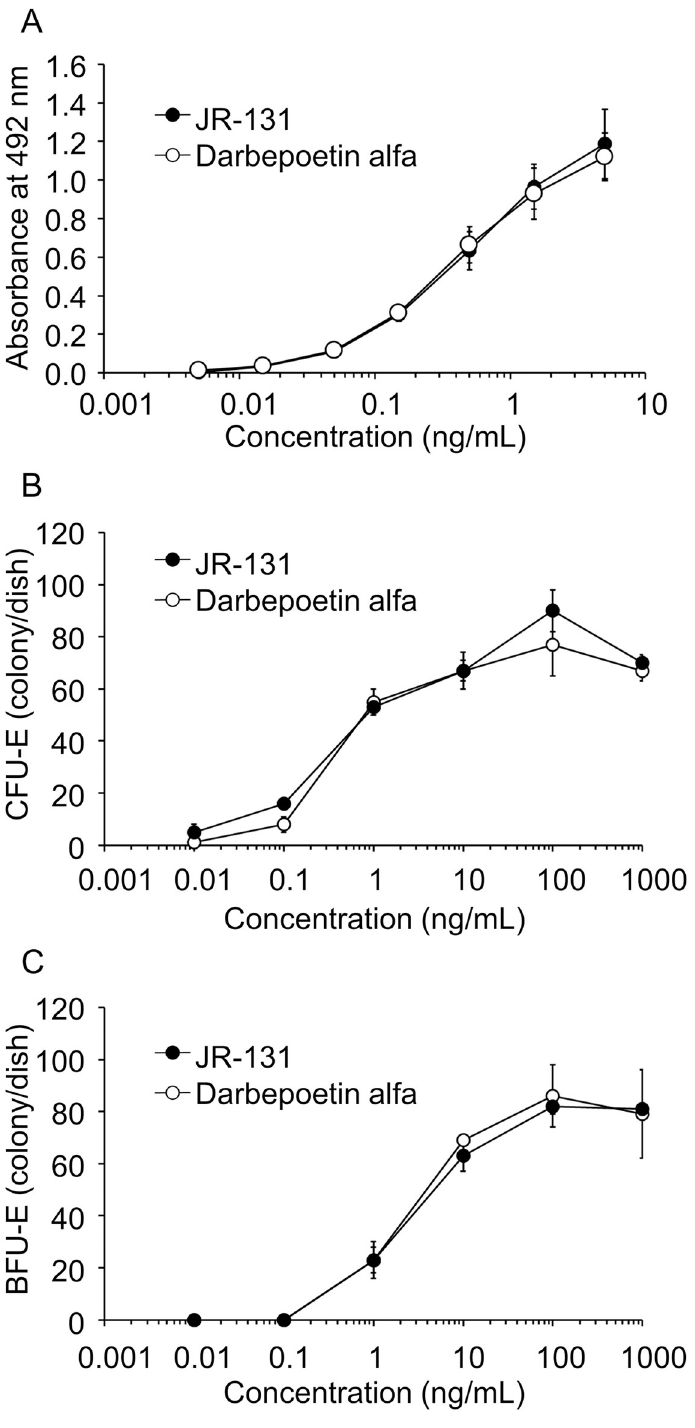
Fig 8. In vitro efficacy assays of JR-131 and darbepoetin alfa. (A) Agonist activity for EPOR was assessed by cell growth assay with BaF/EPOR cells. Biological activity was assessed by the effects of the test substances on the formation of (B) CFU-E- and (C) BFU-E-derived colonies using human bone marrow-derived mononuclear cells. Data are represented as means with standard deviation bars (n = 3).